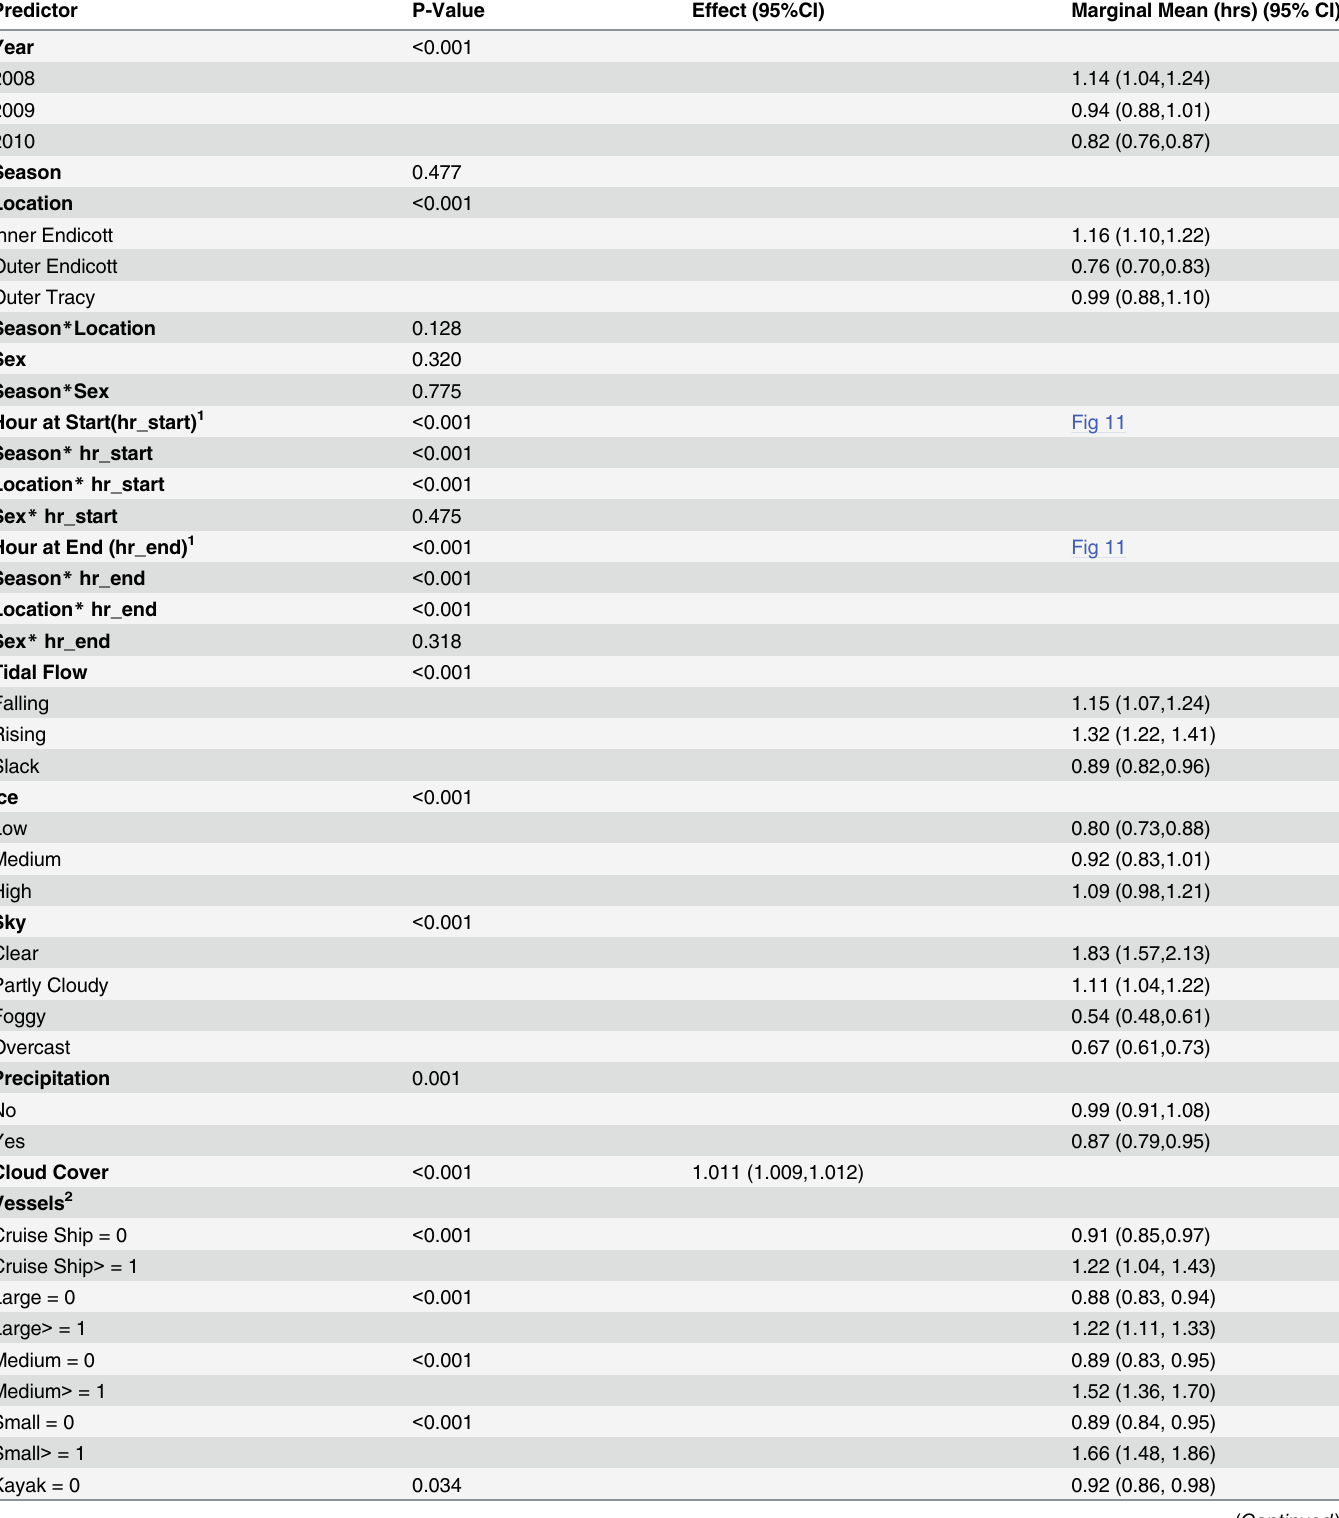
Table 5. Mean haul-out duration in relation to predictor